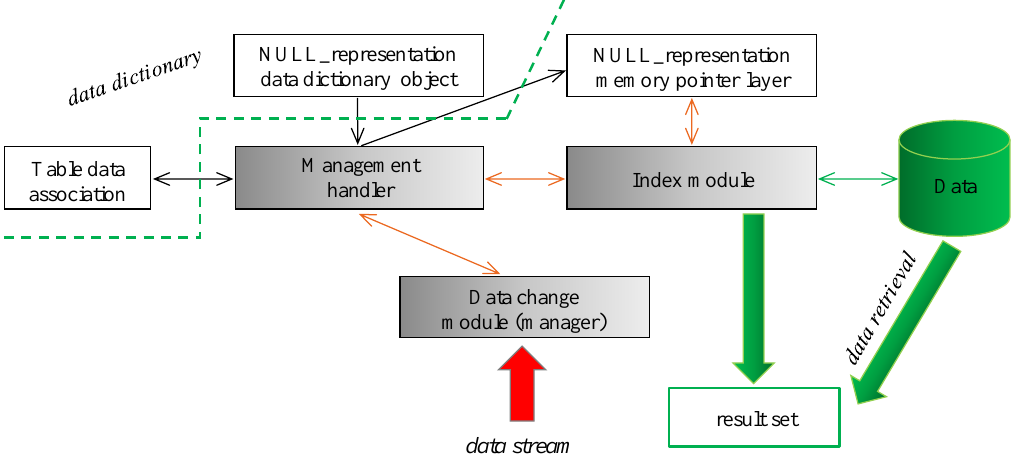
Figure 9. NULL categorization model—proposed architecture.